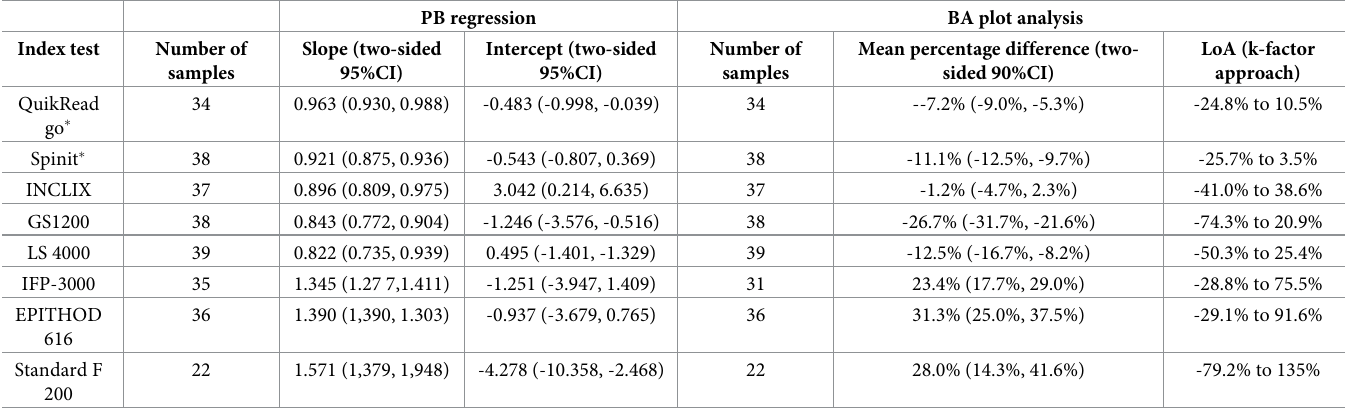
Table 2. Results for Passing–Bablok regression (slope, intercept) and Bland–Altman plot analysis (percentage bias, limits of agreement